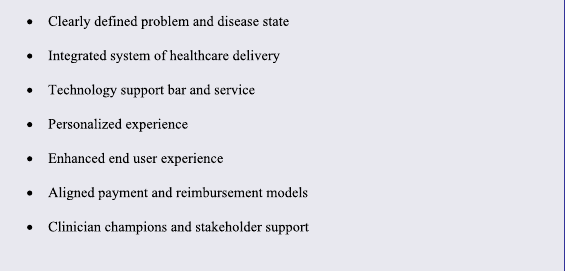
Fig. 1 Listed here are the key features identi fi ed by the workgroup as responsible for success in digital health programs involving